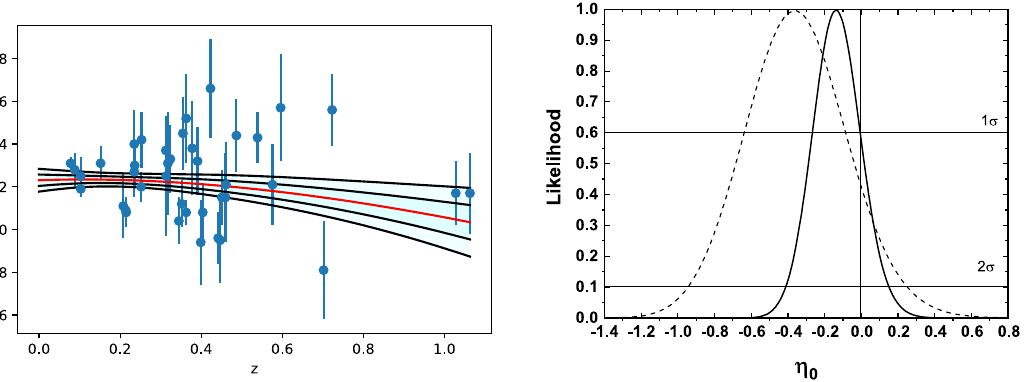
The posteriors distributions for the η( z ) functions. The solid and black lines correspond to Eqs. (9) and (10)